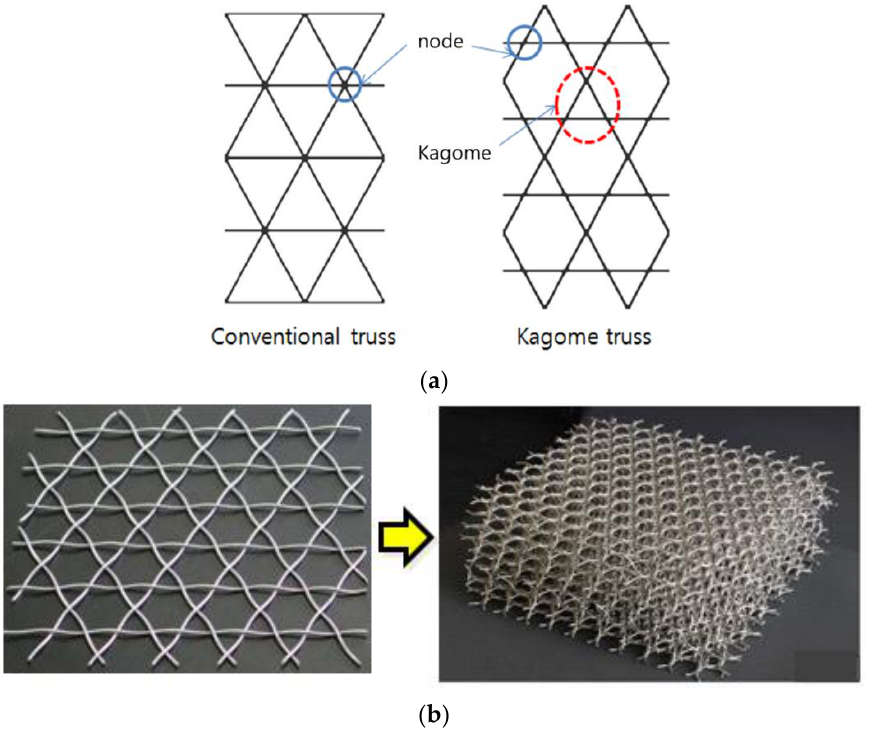
Figure 1. Kagome truss structures and the three-dimensional form [27]. ( a ) Comparison of general truss structure and Kagome structure. ( b ) Comparison of general truss structure and Kagome structure.